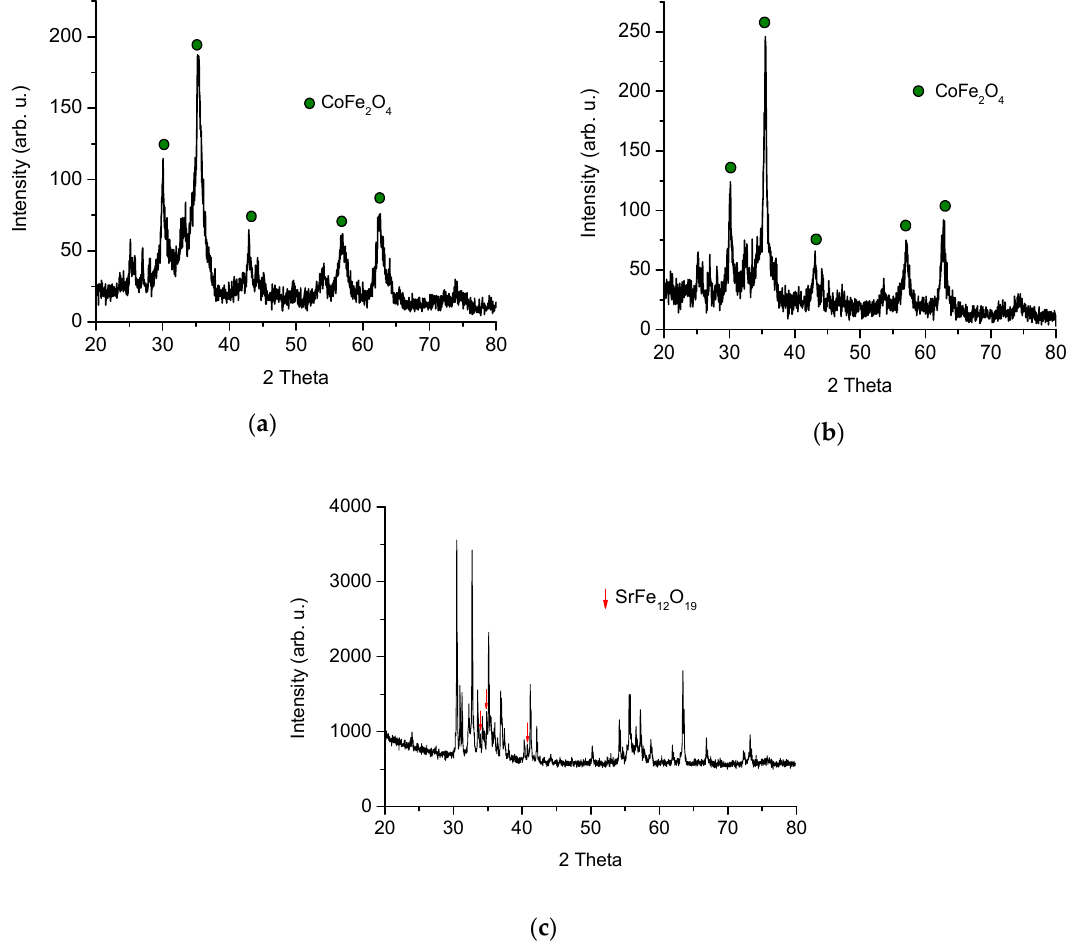
Figure 1. X-ray diffraction (XRD) patterns of Sr 3 Co 2 Fe 24 O 41 : ( a ) as-prepared powder after auto-combustion, ( b ) powder annealed at 600 °C and ( c ) bulk material after three hours at 1250 °C and quenching.